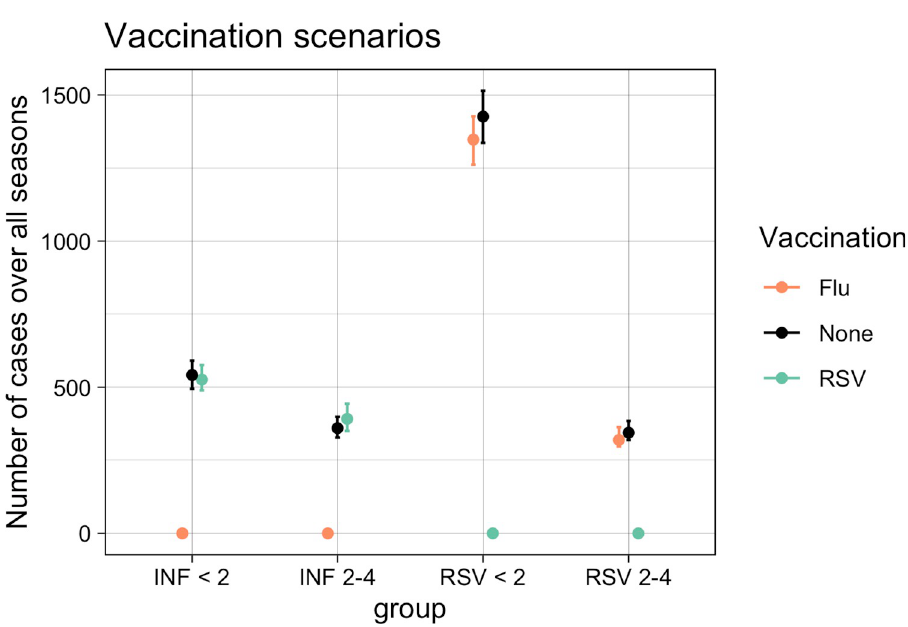
Fig 4. Vaccination scenarios: Number of cases modelled over all seasons, with different vaccination assumptions. Dots represent the median and lines the 95% CrI.